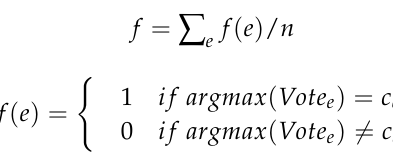
Table 2. Groups of NLSR terms [7]. Representative terms are in italic. Group NLSR Terms 1 starts and ends in runs along boundary , runs along, along edge, contained in edge, 2 encloses, enclosed by in , inside, within, contained within goes to , leads to, goes up to, goes through, bisects, splits, run through, pass through, comes through, cuts across, cuts through, spans, goes across, stretch over, runs across, cuts, intersect, passes, transects, traverses, crosses, break into, divides, separate, goes into, reach into, comes into, enters, runs into, ends outside, comes from, goes out of, run from, stretch from, comes out of, exits, leaves, ends in, ends on, starts in, starts outside, connected to, connects, ends at, starts just inside, ends just inside, starts near, starts just outside, ends just outside, ends